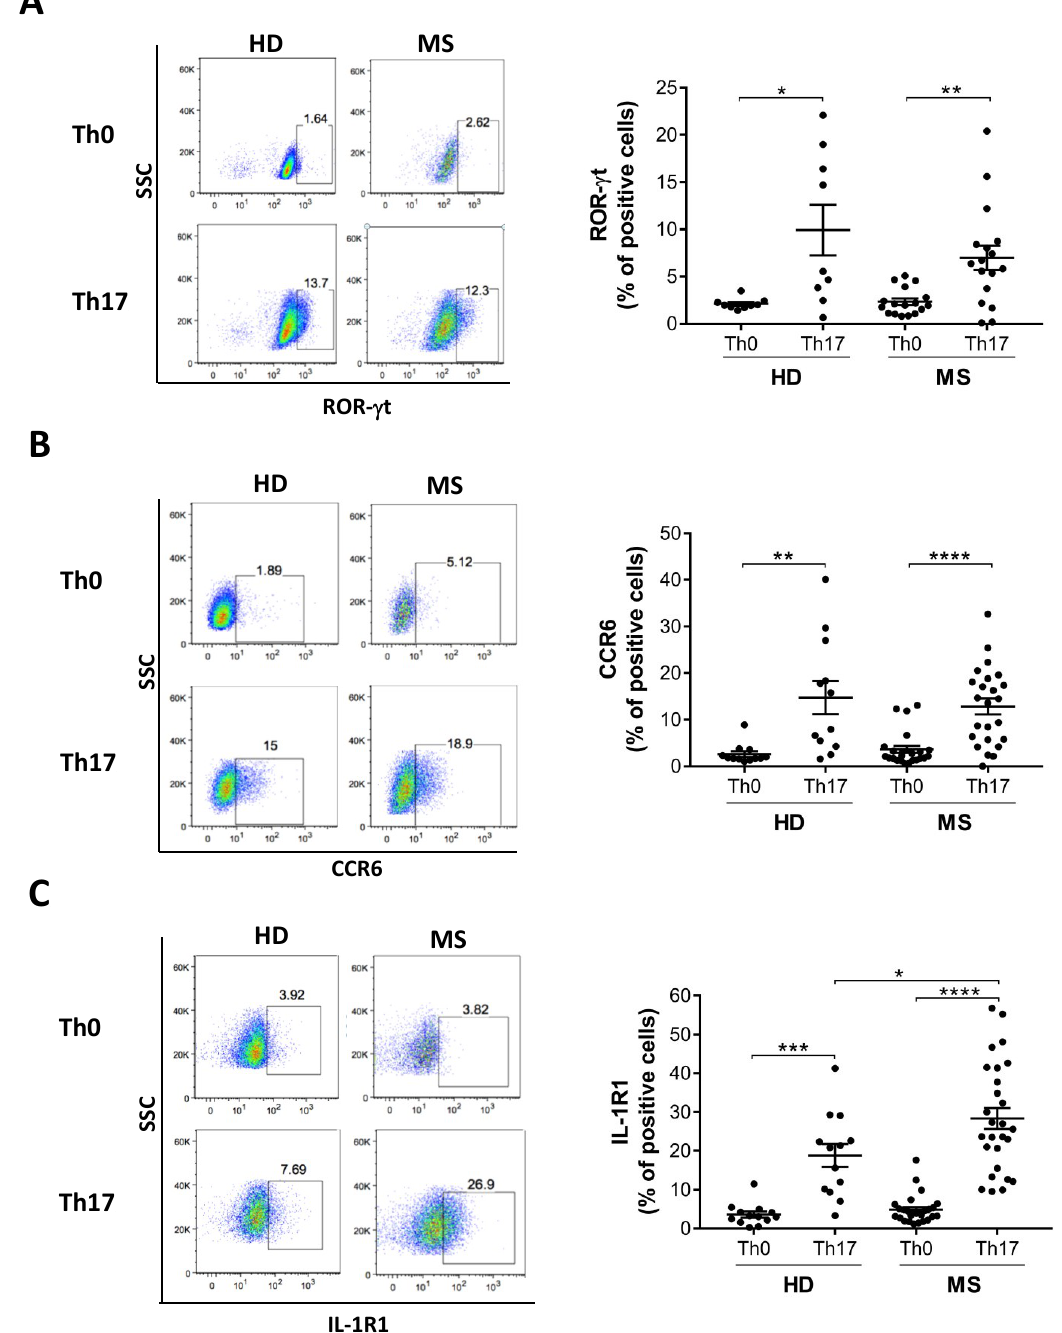
Figure 3. Th17 cells di ff erentiated from MS patients express higher IL-1R1 than those di ff erentiated from healthy donors. Naive CD4 T cells from healthy donors (HD) and multiple sclerosis (MS) patients were cultured with antiCD3-antiCD28 alone (Th0) or antiCD3-antiCD28 + TGF- β , IL-6, IL-23 and IL-1 β (Th17). At 5 days of di ff erentiation cells were stained with specific antibodies against ROR γ t ( A ), CCR6 ( B ), and IL-1R1 ( C ) and analysed by flow cytometry. Graphs represent the results of independent experiments. (* p < 0.05; ** p < 0.01; *** p < 0.001; **** p < 0.0001.).